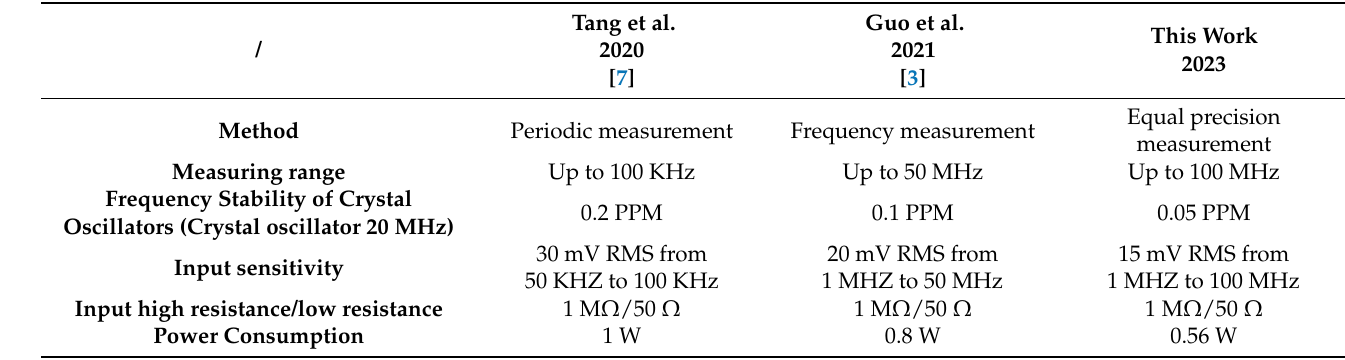
Table 5. Performance